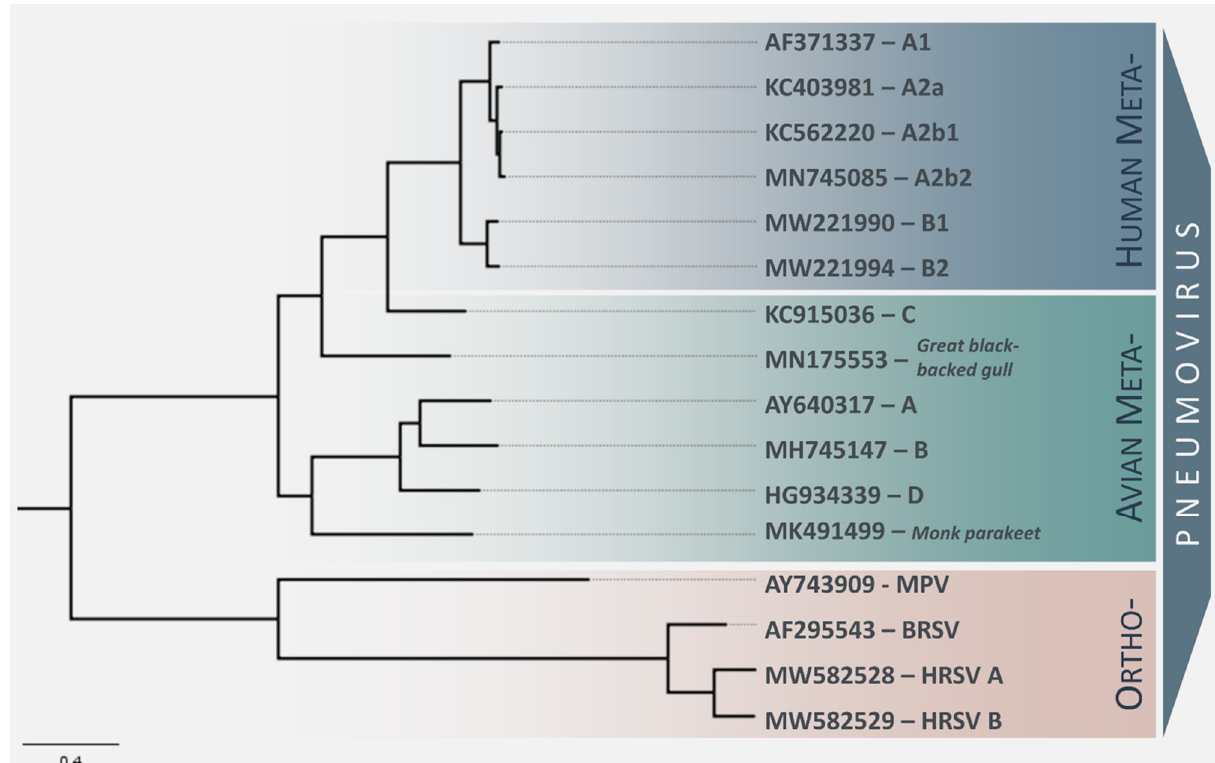
Figure 1. Maximum likelihood phylogeny of metapneumovirus sequences. The phylogenetic tree was constructed using complete genome sequences from NCBI GenBank representing the different subgroups of AMPV and HMPV with orthopneumovirus sequences used as an outgroup. Maximum likelihood phylogeny was performed using a GTR + G model of nucleotide substitution. The tree was generated using bootstrap support of 1000 replications. The tip labels represent the NCBI GenBank accession numbers of respective virus strains, and the scale bar is proportional to the number of nucleotide substitutions per site.